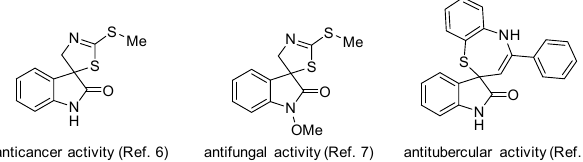
Figure 1. Bioactive oxindoles with thiolation at the C-3 position.